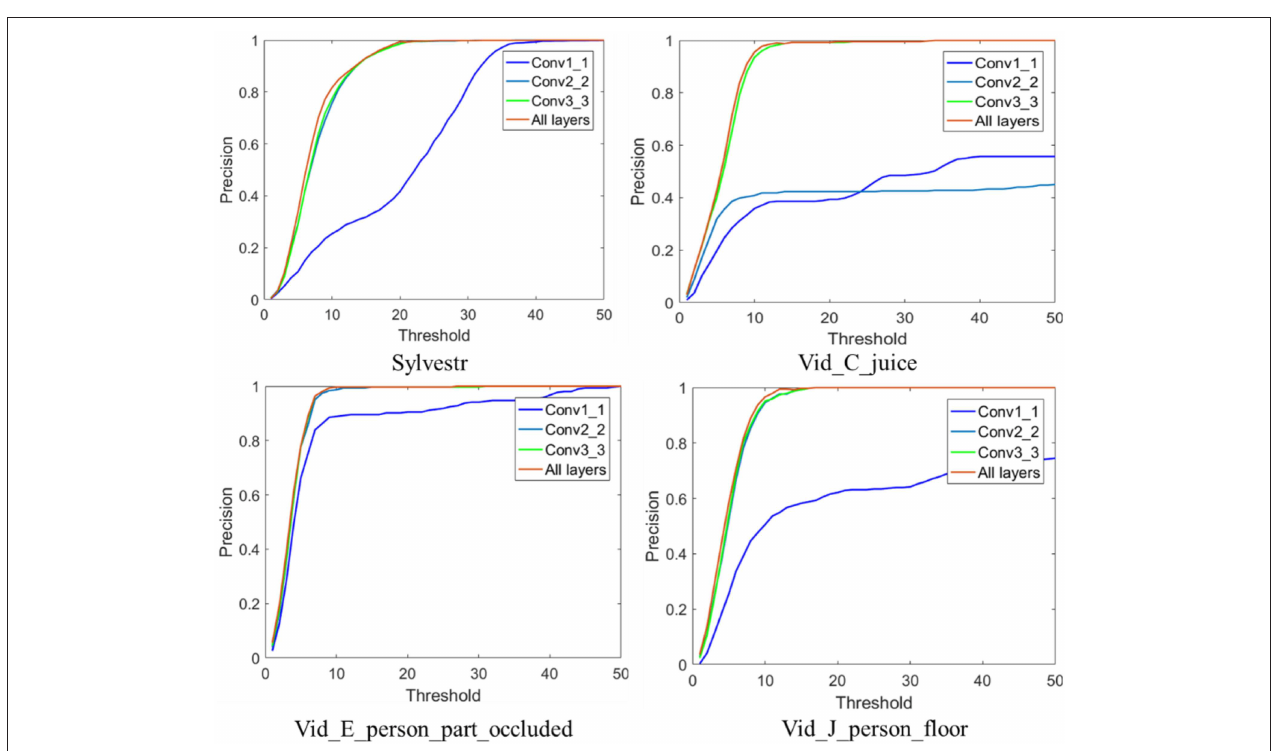
FIGURE 4 | Tracking performance with different feature representation from different convolutional layers of the employed CNN.